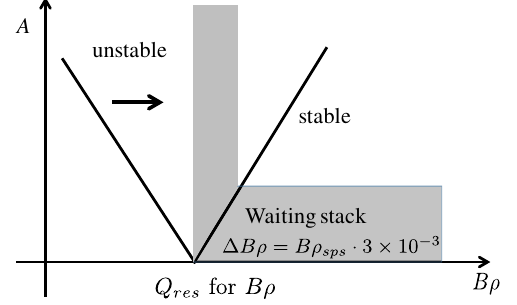
FIG. 4. Steinbach diagram to illustrate COSE slow extraction process: At arrival at the extraction flat-top the tune is set to the resonant one for the lowest momentum particles. Then the beam rigidity B ρ (virtual scaling parameter of magnetic settings) is increased until all particles are extracted. The assumed total momentum spread in the illustration is δ p=p ¼ 3 × 10 − 3 .